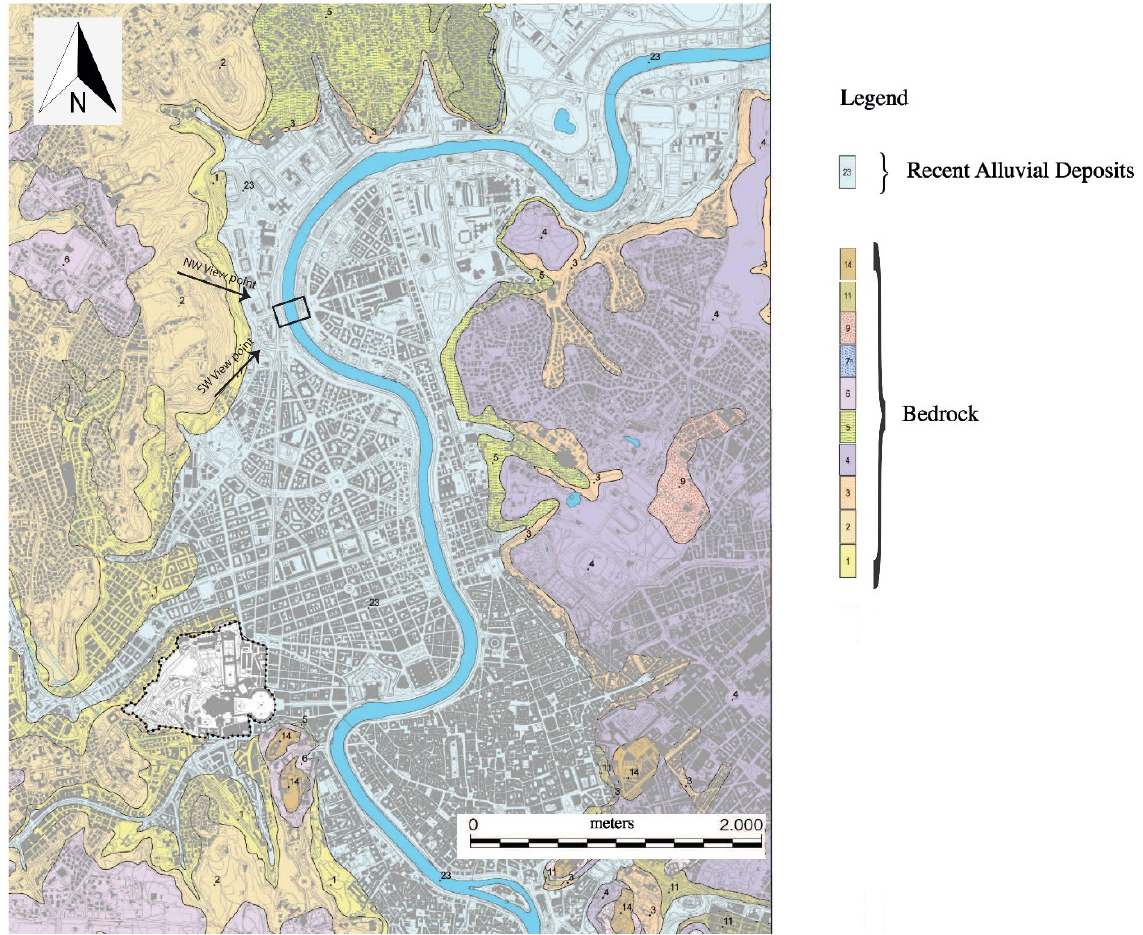
Figure 4. Excerpt of the lithological map of the Rome area (http://www.urbanistica.comune.roma.it/images/uo_urban/prg_vigente/prg_g9_1_00.pdf, accessed on 17 May 2021). The black box highlights the perimeter of the geological 3D model reported in Figure 5.